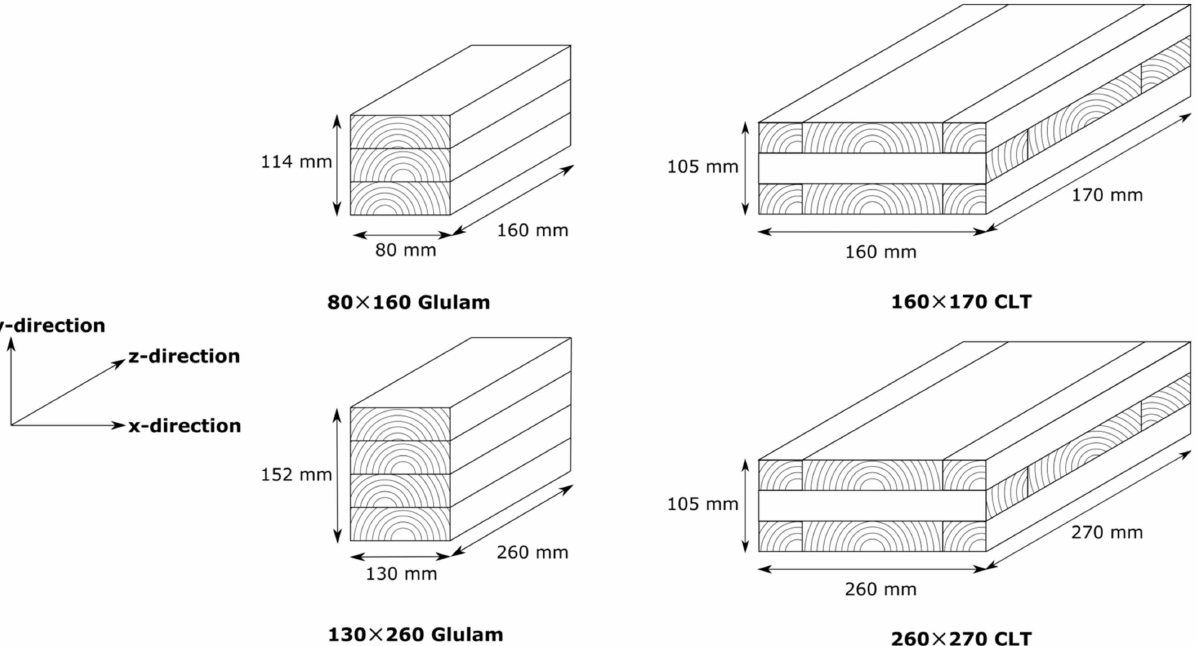
Figure 3. CLT and glulam products used in the test program.